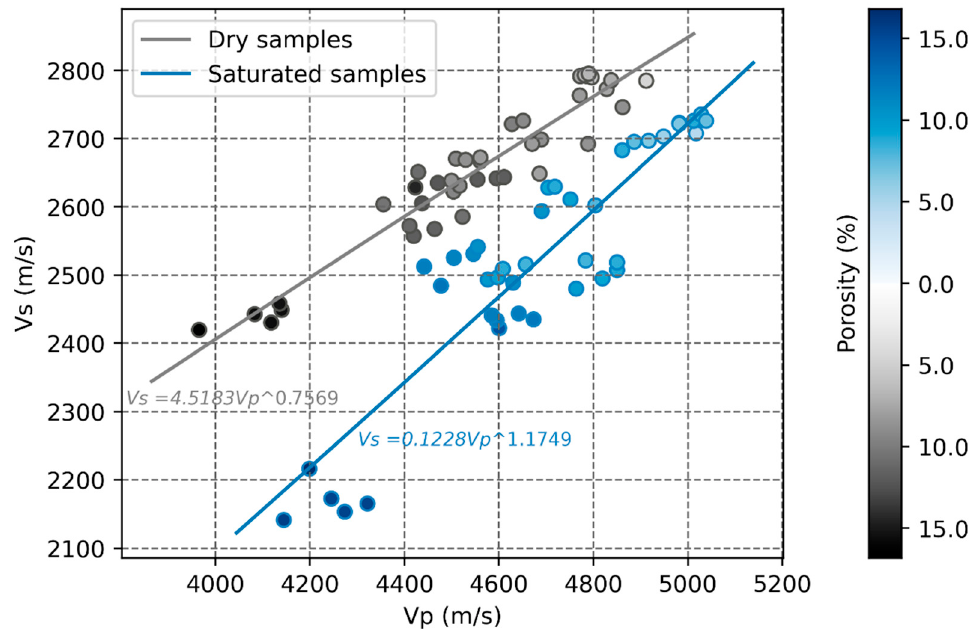
Figure 10. Correlation of P-wave velocities and S-wave velocities of dry samples (grey dots) and saturated samples (blue dots).